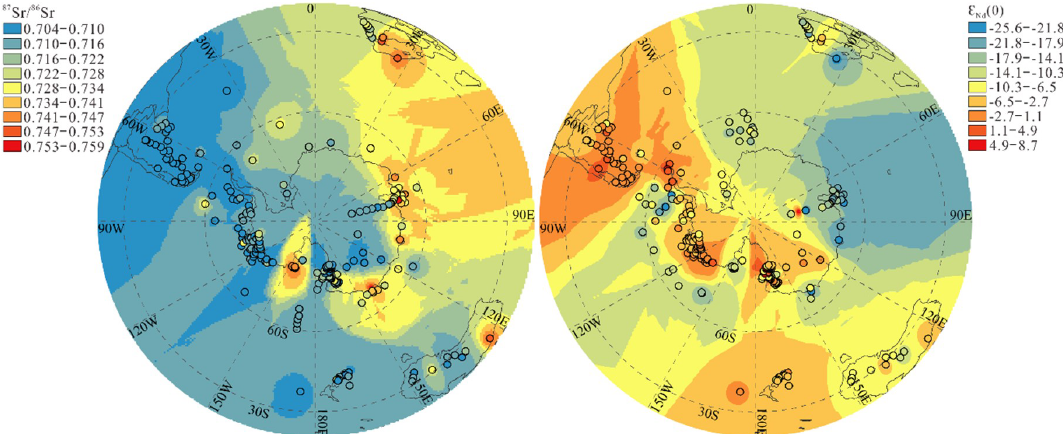
Figure 8. Sr and Nd isotopic compositions of Holocene samples (black circles) from the AIS and ice-free areas on its periphery as well as eolian dust samples (surface samples with no accurate ages) from PSAs in Australia, southern Africa, and South America. The colors were determined by inverse distance-weighted interpolation using